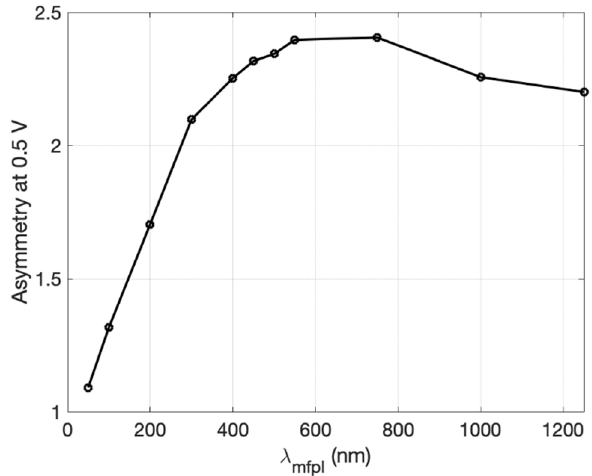
Figure 6. Asymmetry dependence on carrier mean-free-path length for a graphene Z-diode. For